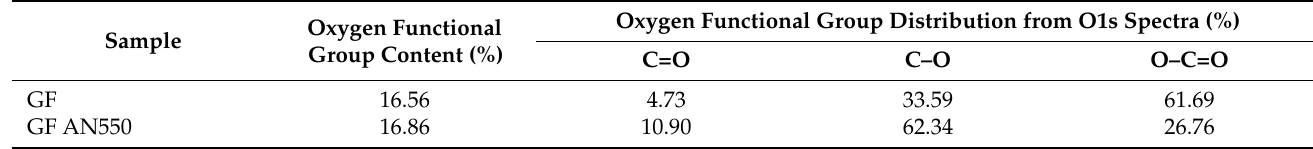
Figure 9. XPS survey spectra of graphite felt in as-received condition and after thermal oxidation at 550 °C for 5 h. Table 4. Oxygen functional group content and distribution on GF samples.